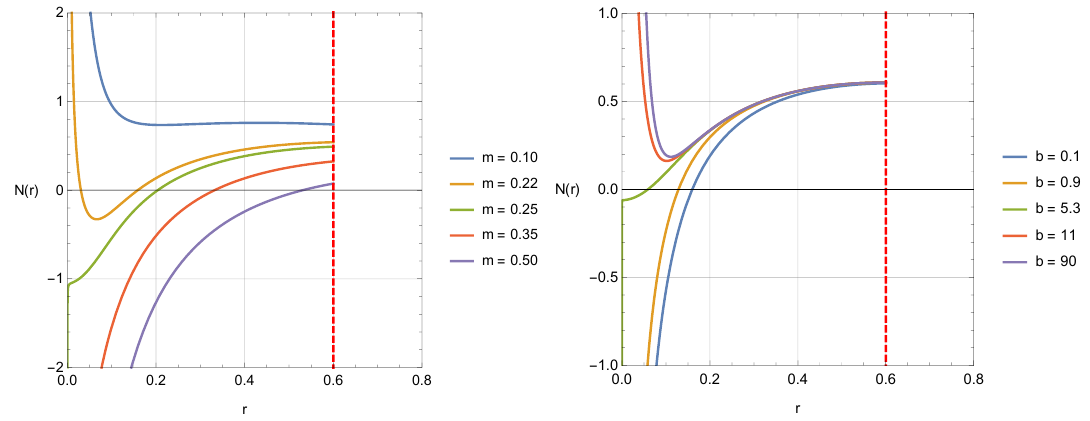
Figure 3 . The metric function N ( r ) as a function of r for q = 0 : 1, (cid:3) = 1, and r c = 0 : 6; the cavity radius is indicated by the red dashed line. Left : (cid:12)xed vacuum polarization ( b = 10 : 22) and varying mass parameter m . Right : (cid:12)xed mass ( m = 0 : 18) and varying b . In both (cid:12)gures the marginal case appears in